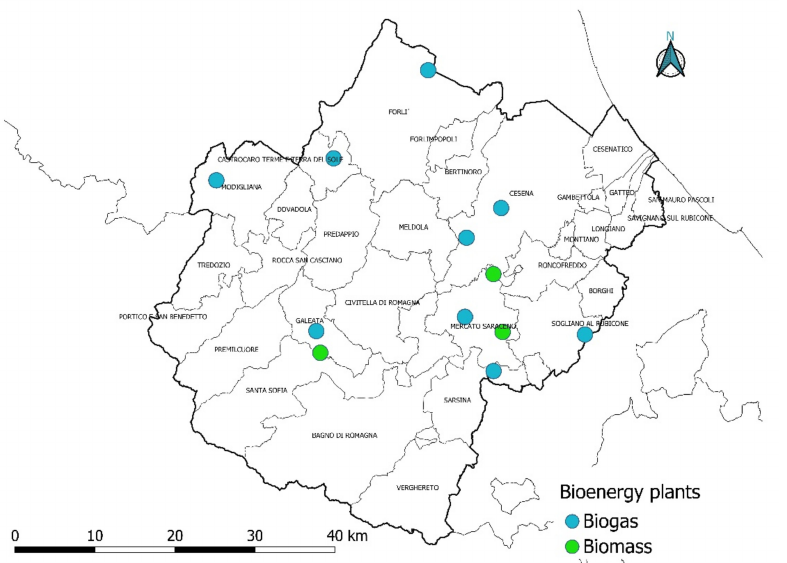
Figure 6. Forl ì -Cesena’s municipalities classification based on the amount of processed sewage sludge at the territorial